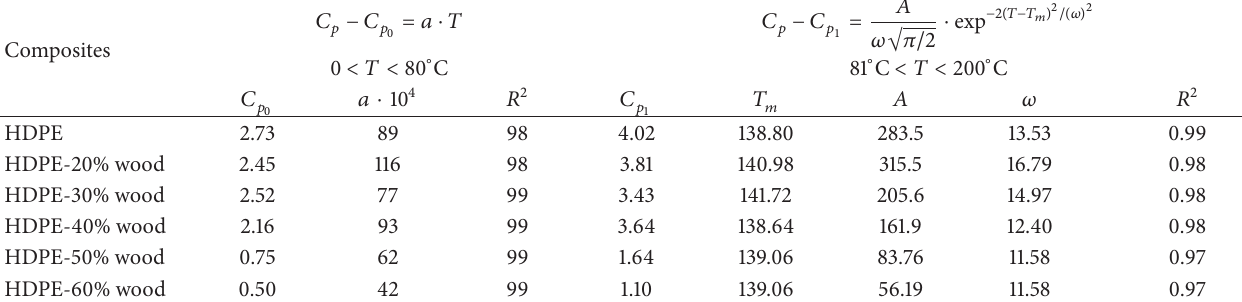
Table 3: Linear regression of specific capacity according to the temperature and wood fillers.